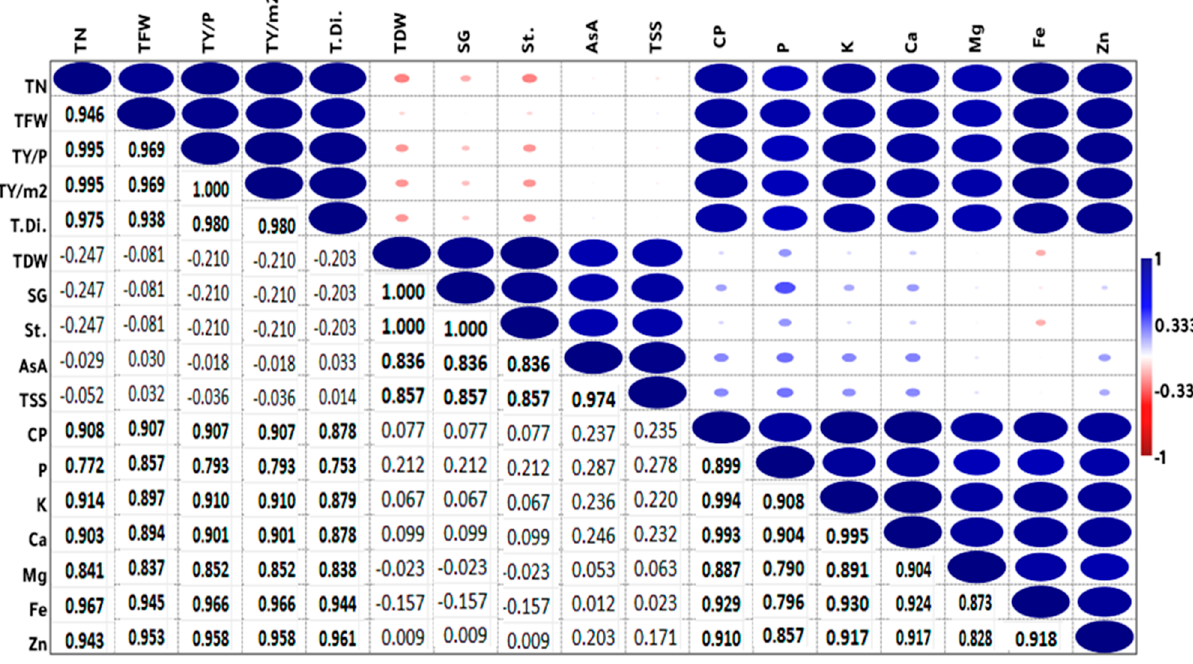
Figure 4. Correlation analysis between different traits of potato plants grown under water deficit and treated with ZnO and SiO 2 nanoparticles. TN: tuber number; TFW: tuber fresh weight; TY/p: tuber yield per plant; TY/m 2 : tuber yield per m 2 ; T.Di: tuber diameter; TDW: tuber dry weight; SG: specific gravity; ASA: ascorbic acid; TSS: total soluble solids; CP: crude protein; St.: starch. Minerals: P, K + , Ca 2+ , Mg 2+ , Fe 2+ , and Zn 2+ . Values in bold are different from 0 with a significance level alpha = 0.05. Color and size changes represent the degree of correlation. The larger the circular area and the darker the color, the stronger the correlation, and vice versa. Red color represents negative correlations and blue color represents positive